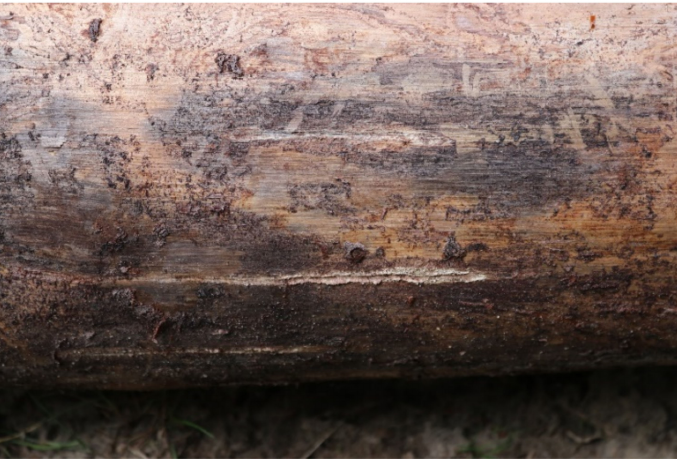
Figure 2. Tomicus piniperda galleries engraving the sapwood.